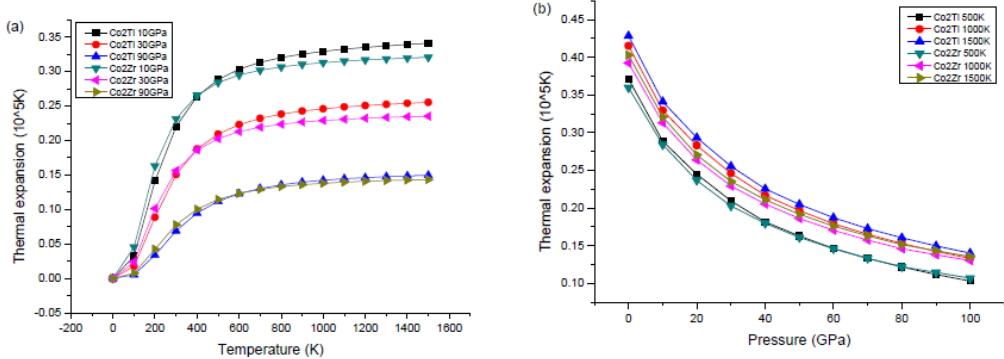
Figure 6. Thermal expansion α as a function of ( a ) temperature at 10, 30, and 90 GPa; and ( b ) pressure at 500, 1000, and 1500 K for Co 2 Zr and Co 2 Ti.